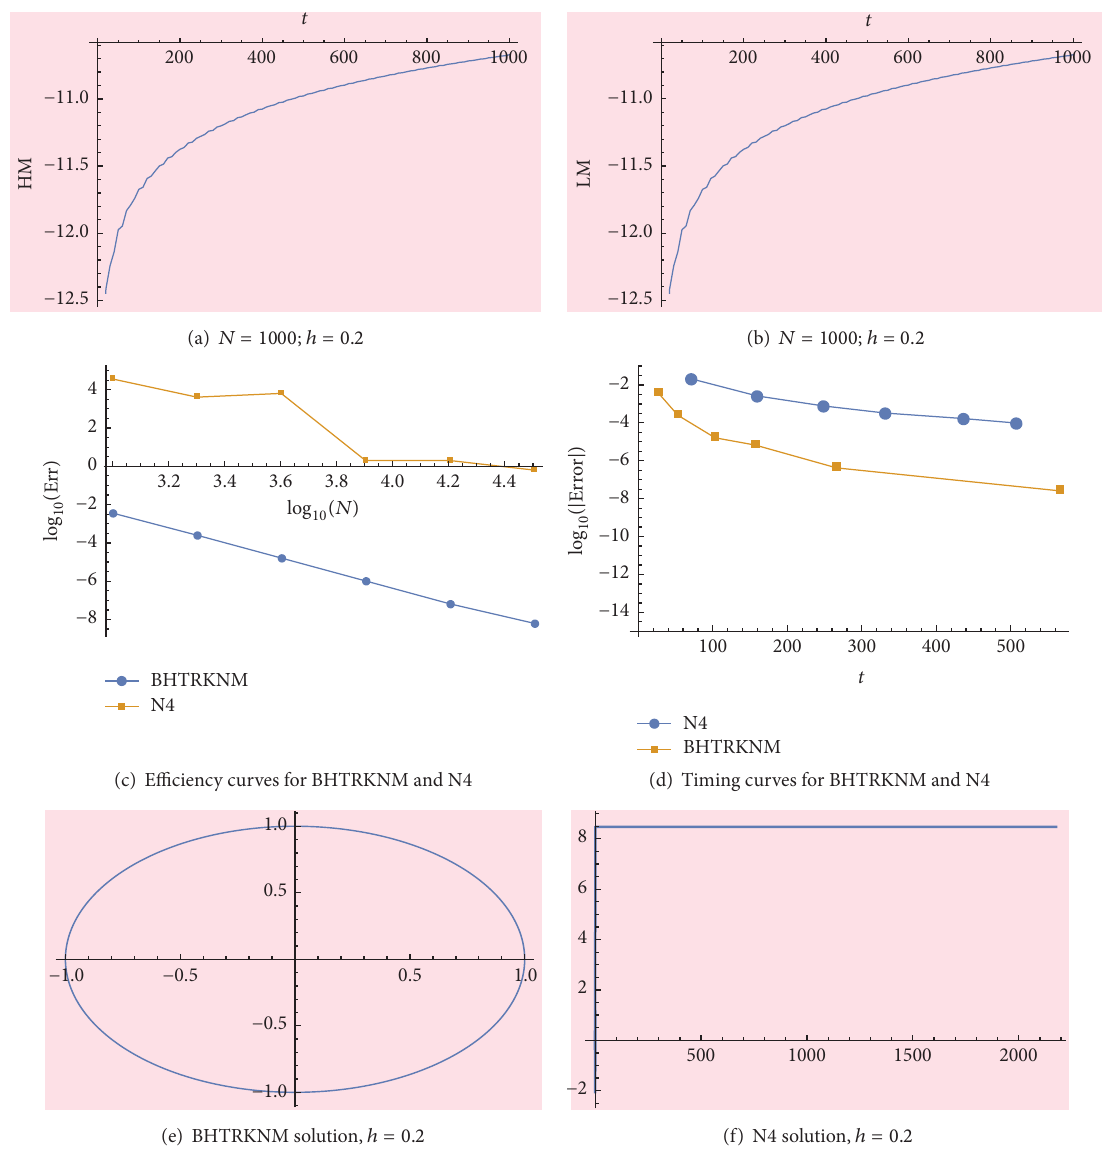
Figure 7: Perturbed Kepler problem: the logarithm of the global error of the Hamiltonian EH = |𝐻 𝑛 − 𝐻 0 | against 𝑡 for ℎ = 0.2 and the momentum EL = |𝐿 𝑛 − 𝐿 0 | are presented in (a) and (b), respectively. In (c) we compare the efficiency curves for the BHTRKNM and N4. Timing comparison is provided in (d). It is clear from the timing curves that BHTRKNM is very